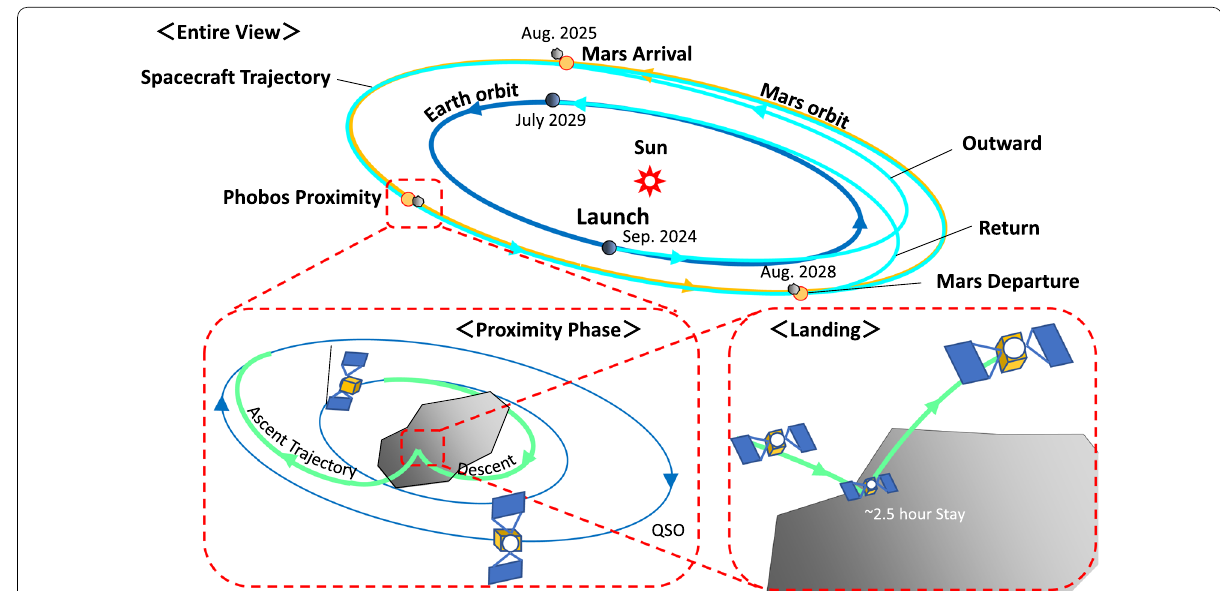
Fig. 2 The mission profile of MMX. See text for